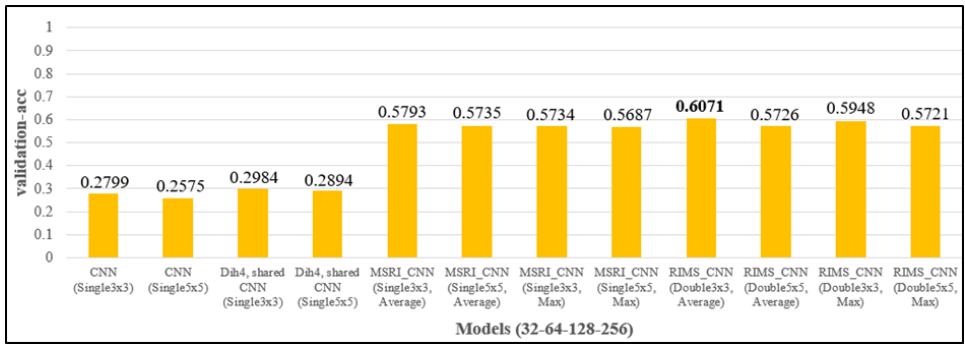
Figure 14. The results of different designs validated on the fixed-angle-rotated CIFAR-10.